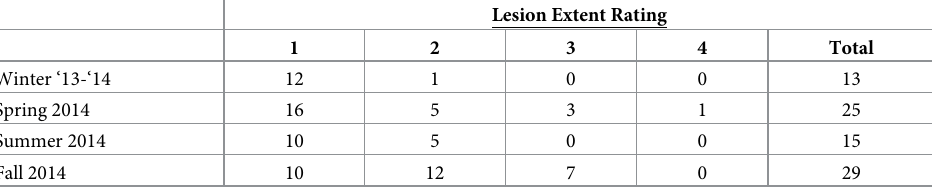
Table 3. Extent of skin lesion coverage measured as categorical